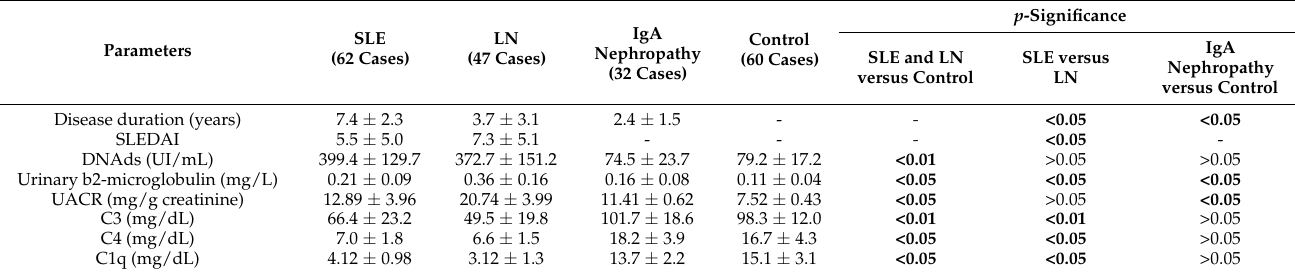
Table 2. Disease activity parameters in the patient